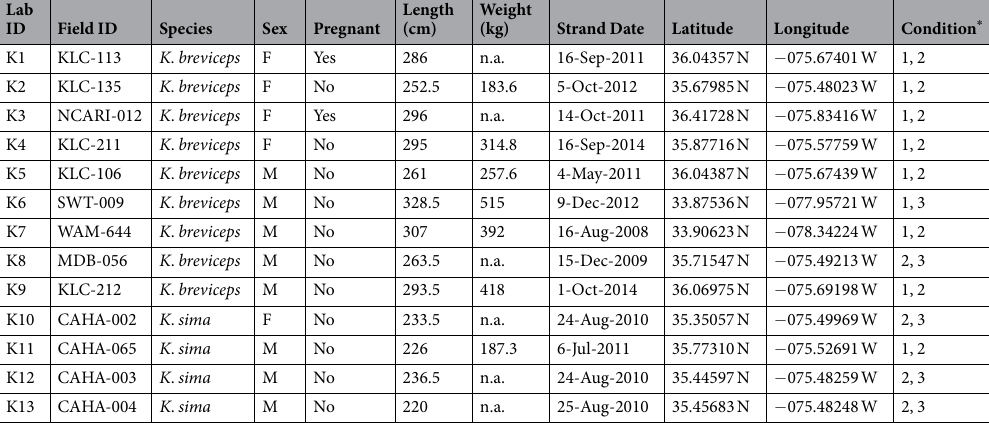
Table 3. Stranded individuals of K . breviceps and K . sima examined in this study and associated metadata for each sample (n.a. = data not available). * Carcass condition at stranding (left) and at examination (right): 1 = Alive, 2 = Fresh Dead, 3 = Moderate